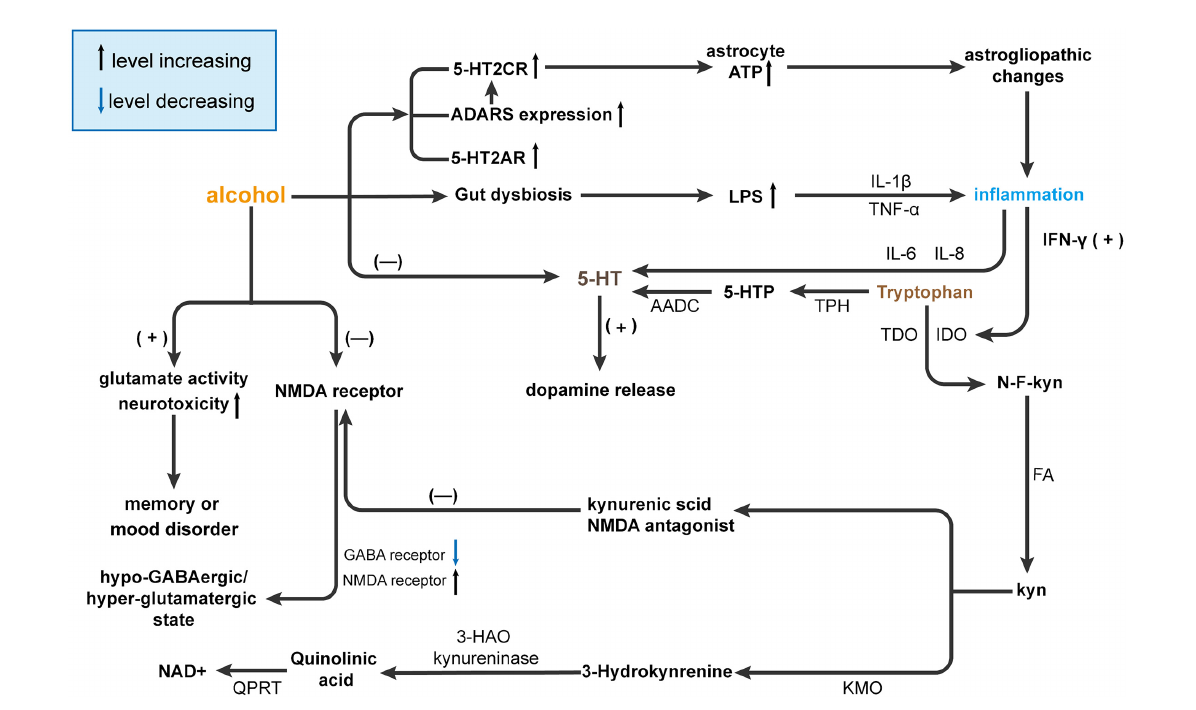
FIGURE3 Alcohol affects brain function by interfering with 5-HT metabolism. Alcohol causes gut dysbiosis resulting in increased lipopolysaccharides (LPS) levels and the release of inflammatory cytokines [tumor necrosis factor (TNF)- α and IL-1 β ], and ultimately, inflammation affects 5-HT levels in the brain via IL-6 and IL-8. Then, 5-HT promotes the release of dopamine. On the other hand, alcohol can affect the expression of receptors such as 5-HT2CR, adenosine deaminases acting on RNA (ADARS), and 5-HT2AR. The increase in receptor interferes with ATP and eventually leads to hyperammonemia and inflammation, which affects 5-HT metabolism through IFN- γ but also directly affects 5-HT content in the brain. Usually, most tryptophan is converted to 5-HT by tryptophan hydroxylase (TPH) and ADCC. However, in the presence of alcohol, tryptophan is converted to Kyn by activating indoleamine 2,3-dioxygenase (IDO) and tryptophan-2,3-dioxygenase (TDO). Kyn inhibits NMDA receptors by producing kynurenic acid and activates N-methyl-D-aspartatic acid (NMDA) receptors by producing quinolinic acid by kynurenine 3-monooxygenase (KMO) and 3-hydroxy-anthranilic acid dioxygenase (HAO). NMDA receptor activation can reduce GABA receptors and increase NMDA receptors leading to a hypo-GABAergic/hyperglutamatergic state. At the same time, NMDA receptors can increase glutamate activity and neurotoxicity and ultimately lead to memory or mood disorders. AADC, aromatic l-amino acid decarboxylase; GABA, γ -aminobutyric acid; HAO, hydroxy-anthranilic acid dioxygenase; IDO, Indoleamine 2,3-dioxygenase; KMO, Kynurenine 3-monooxygenase; Kyn, kynurenine; LPS, lipopolysaccharides, NAD + , nicotinamide adenine dinucleotide; NMDA, N-methyl-D-aspartatic acid; QPRT, quinolinate phosphoribosyltransferase; TDO,